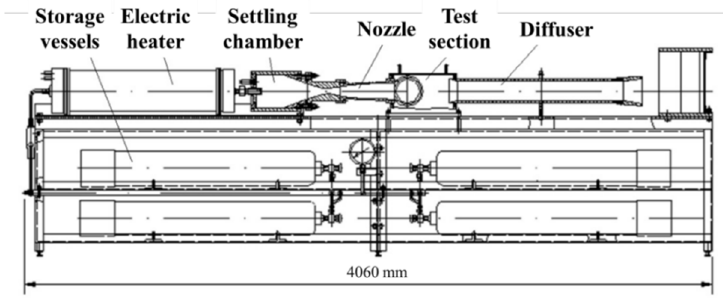
Figure 1. Schematic of MAF.